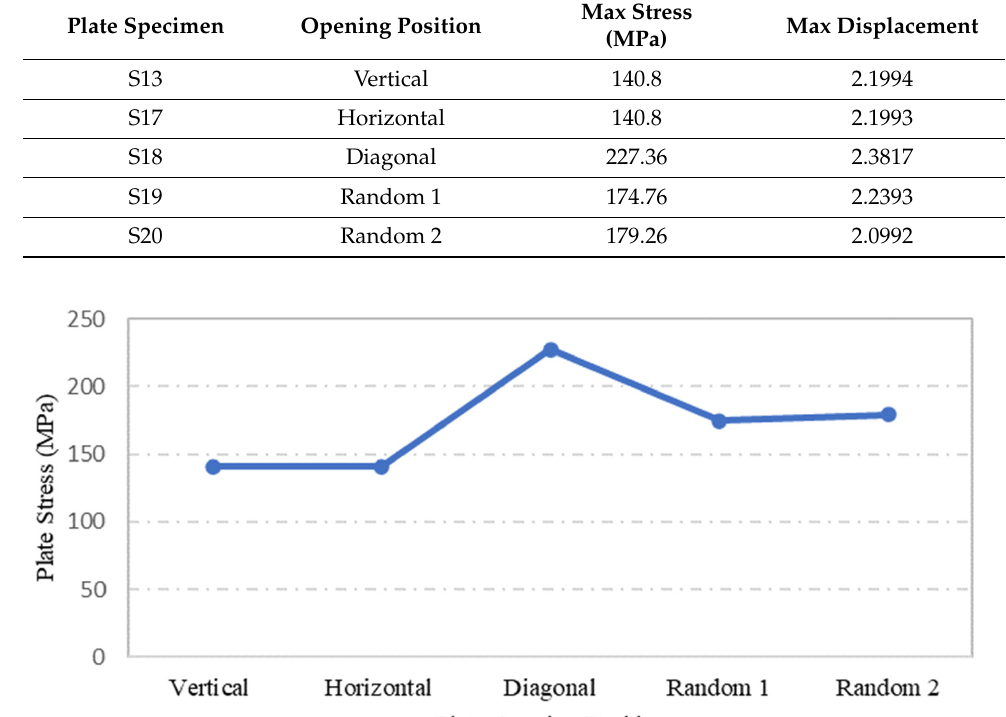
Figure 20. Influence of plate opening positions on plate maximum stress.